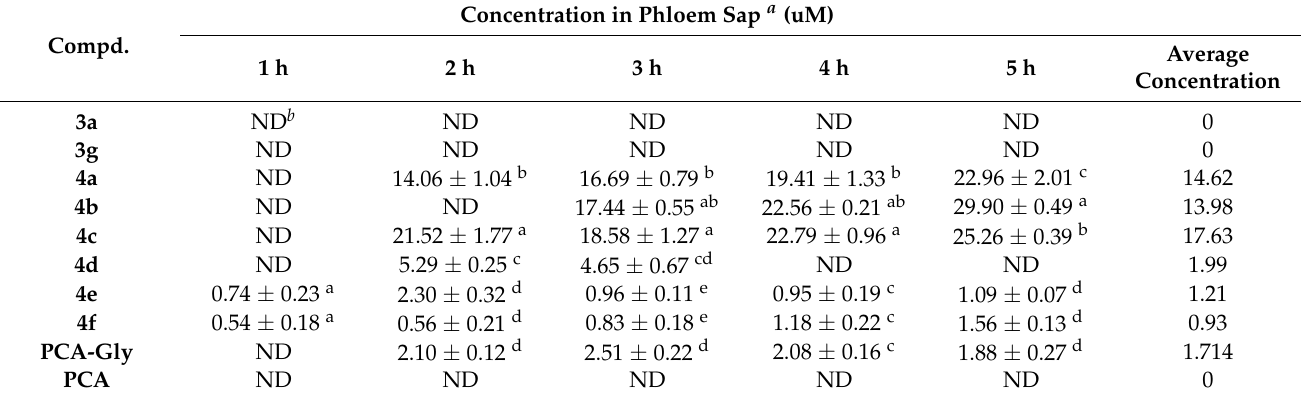
Table 1. Concentrations of compounds 3a , 3g , 4a – 4f , PCA-Gly , and PCA in phloem sap of castor bean seedlings at 1~5